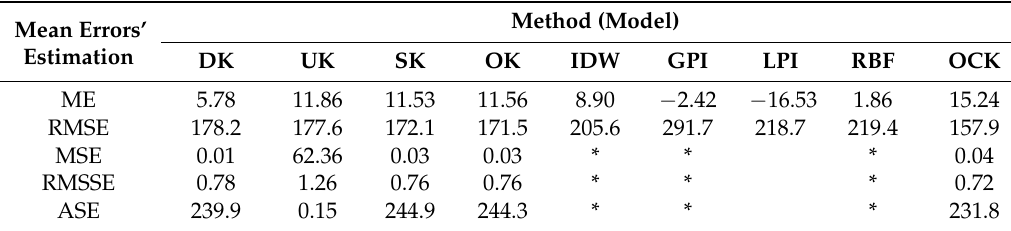
Table 3. Cross-validation statistics computed for interpolation models.